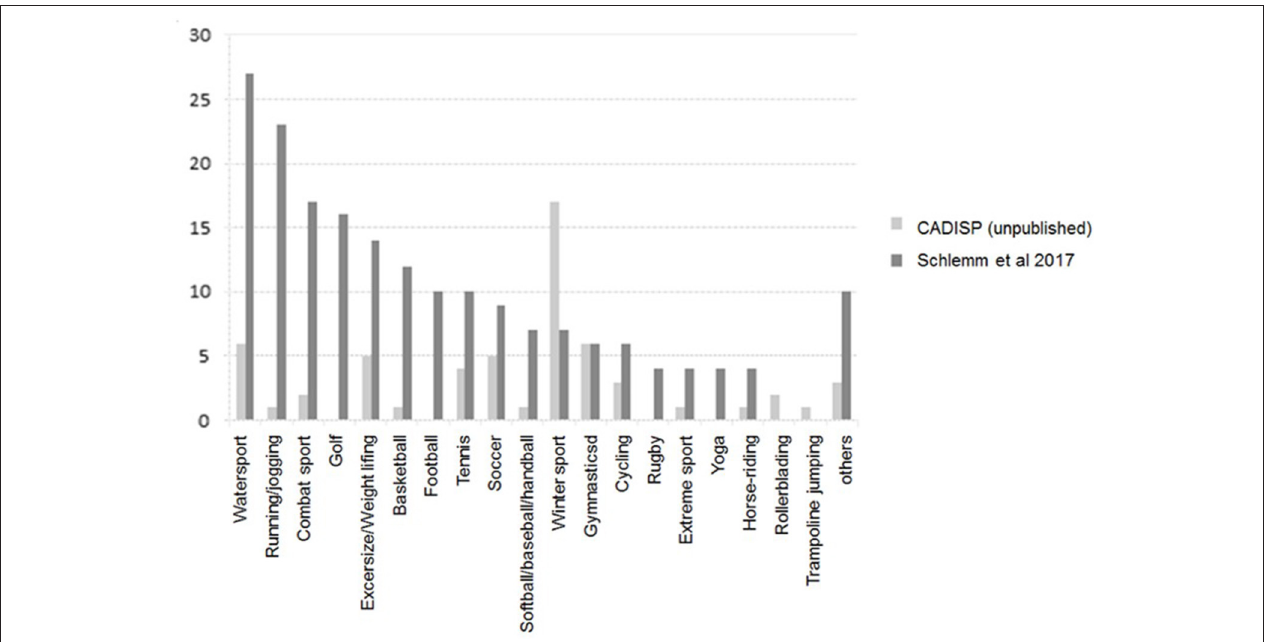
FIGURE 2 | Frequency of CeAD-associated sport types in the review of case series by Schlemm et al. (7) and in the CADISP study